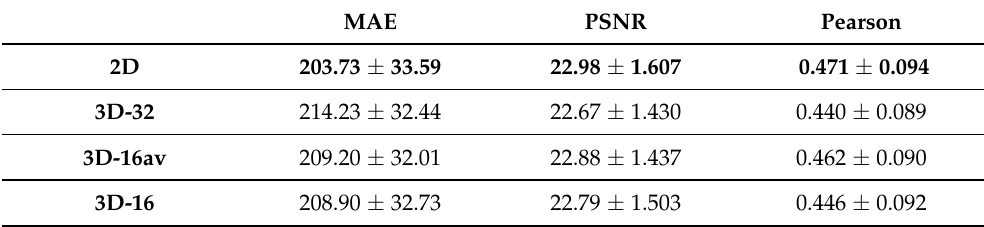
Table 19. Pelvis dataset Bone with U-net. Mean Absolute Error, PSNR and Pearson coefficient from U-net using different convolutions and reconstructions in the Pelvis data set within the